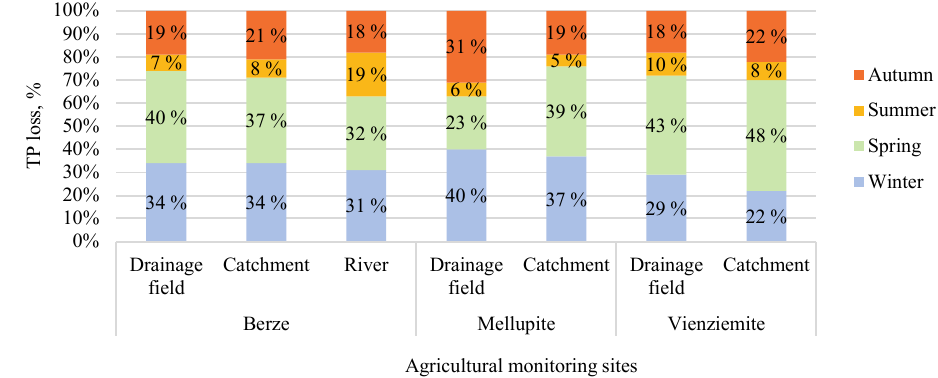
Fig. 9. TP seasonal losses (kg ha –1 ) in agricultural monitoring sites, time period 1995–2020 (drainage field, catchment) and 2005–2020